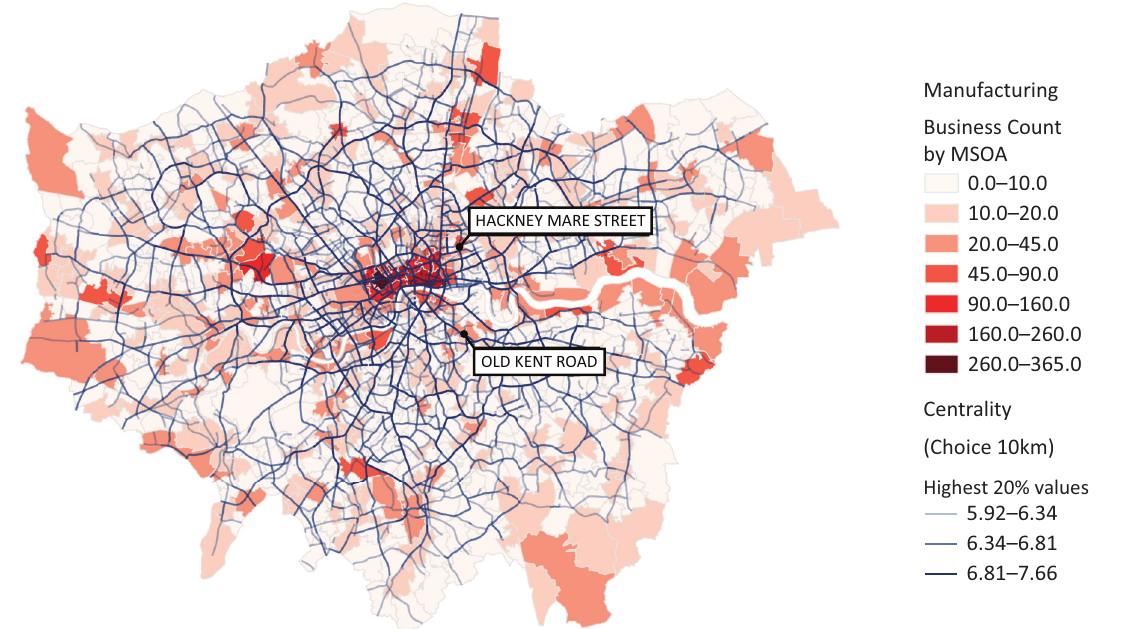
Figure 1. Concentrations of manufacturing businesses in London. The map shows the location of the Hackney Mare Street and the Old Kent Road case studies in London used in this article. Sources: Image elaborated by Nicolas Palominos Ortega using business count data from the Directory of London Businesses (London Data Store, 2019), measured by MSOAs; cen‐ trality data retrieved from Space Syntax